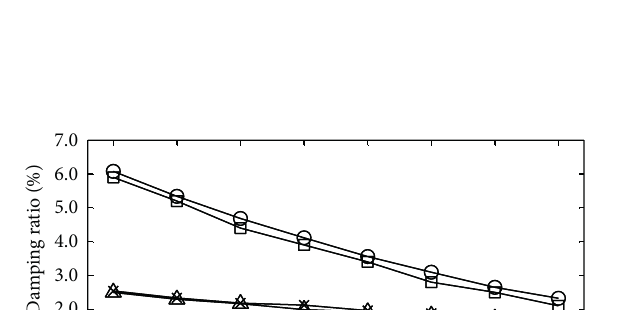
Figure 14: Test and fitted result based on SISO dFRF.